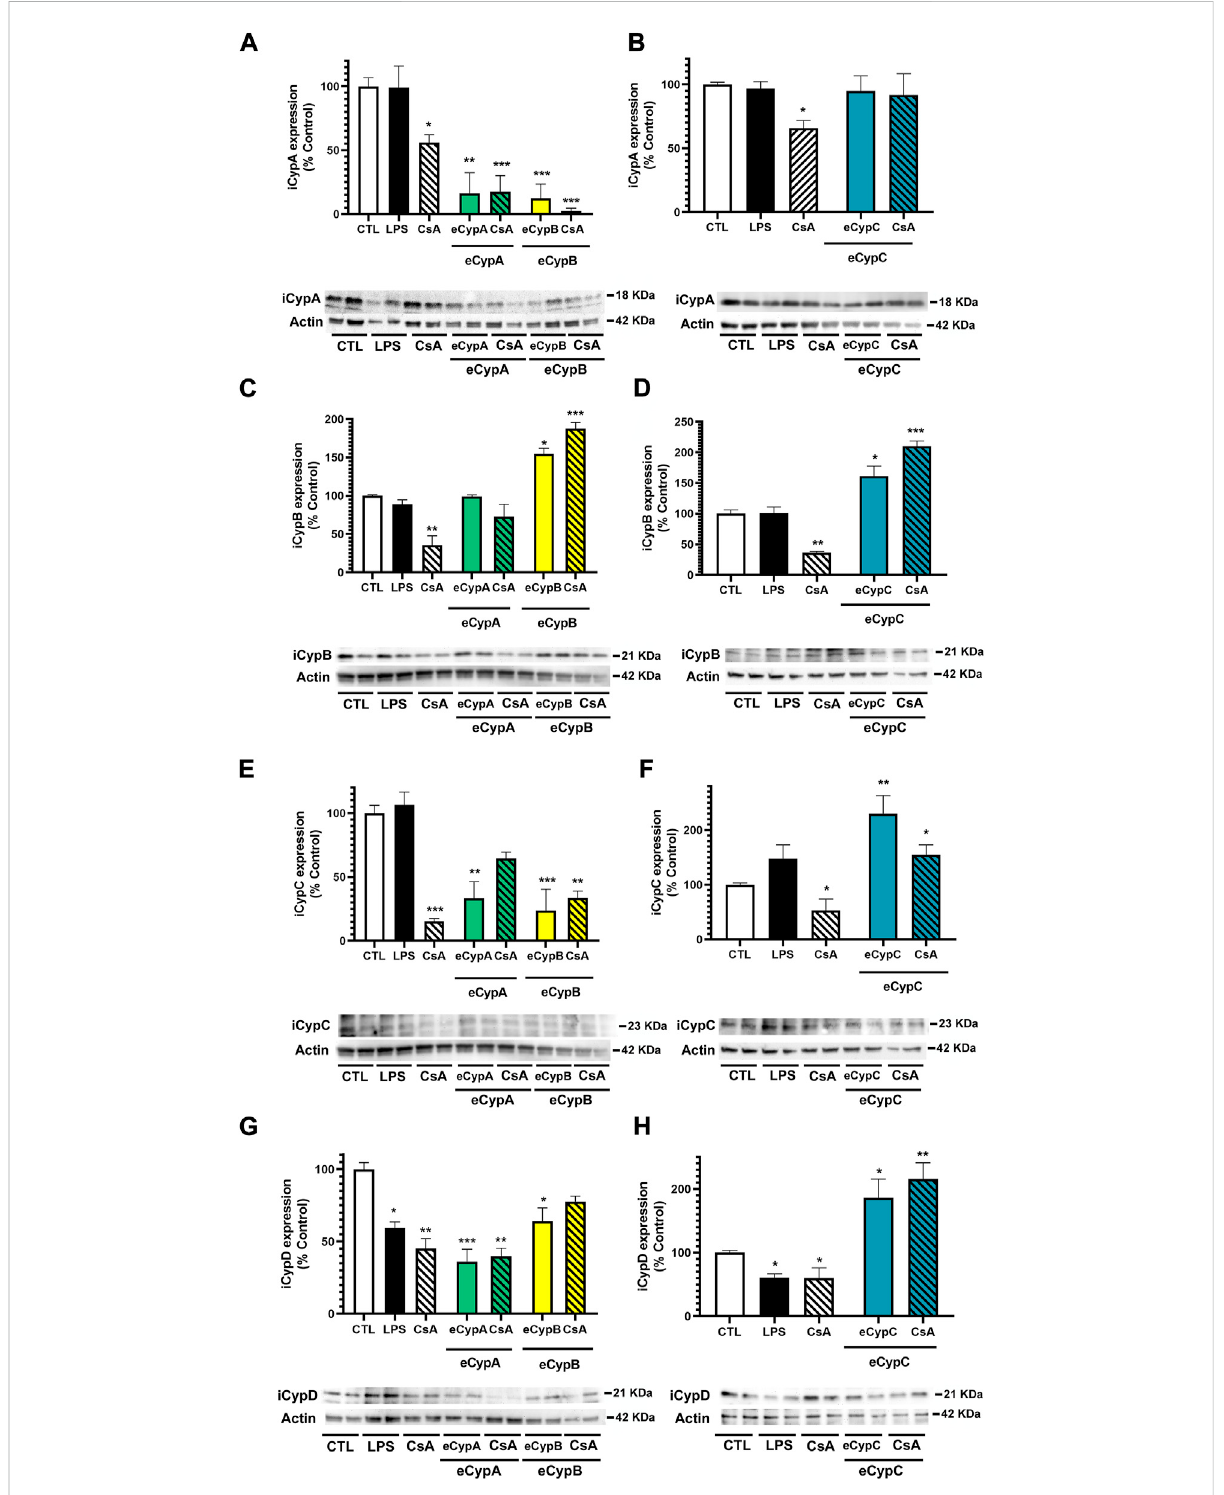
DeterminationofeCyps effectsonintracellular expression ofCypA,CypB,CypC andCypD. (A) iCypAlevels aftereCypAandeCypB addition. (B) Expression of iCypA when endothelial cells weretreated with eCypC. (C) iCypB levels after treatment with eCypA and eCypB. (D) Effect of eCypC on intracellular expression of CypB. (E) iCypC expression levels after eCypA and eCypB addition. (F) eCypC effects on its intracellular levels. (G) Expression ofiCypDinpresenceofeCypAandeCypB. (H) LevelsofiCypDaftertreatmentwitheCypC.Proteinbandexpressionwasnormalized by actin levels. The quanti fi ed bands are indicated by their molecular weight. Data are mean ± SEM of three independent experiments performed by duplicate and expressed as percentage of control cells. Statistical signi fi cance evaluated by one way ANOVA and Tukey ’ s tests (* p < 0.05, ** p < 0.01, *** p < 0.001, compared to control